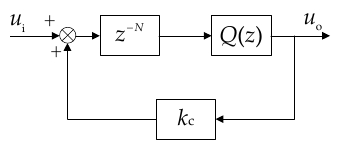
Figure 6. The structure diagram of the RC.